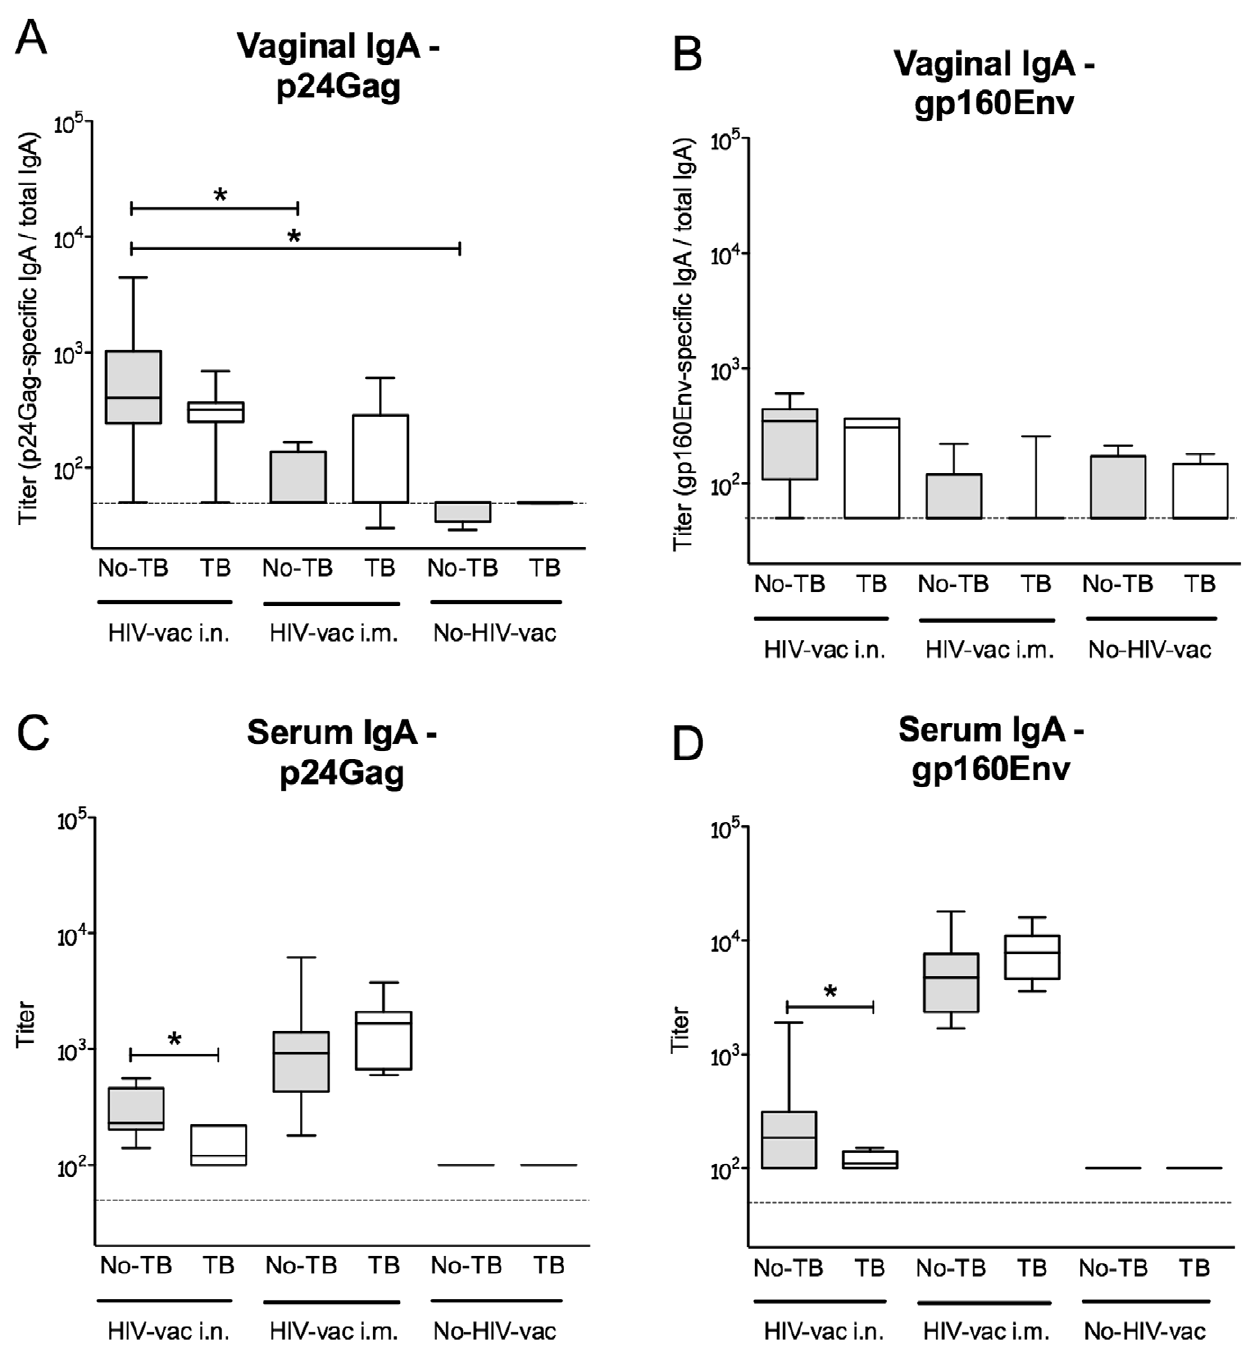
Figure 1. HIV-specific vaginal secretory and serum IgA in uninfected and Mtb -infected C57BL/6 mice post-vaccination with MultiHIV DNA/protein. Uninfected C57BL/6 mice, or Mtb aerosol-infected mice, were immunized and boosted with MultiHIV DNA/protein as described in Materials and Methods. Vaginal secretions were collected 4 wk post-vaccination and HIV p24Gag-specific and gp160Env-specific IgA were determined in vaginal washings (A, B) and serum (C, D) as described in Materials and Methods. The median endpoint titer of 6–8 mice/group from one individual experiment is shown as a solid line. The box defines the 75th and 25th percentiles and the whiskers define the maximum and minimum values. Dashed line indicates the ELISA sensitivity threshold. (*: P , 0.05). HIV-specific IgA levels were examined in two separate experiments.